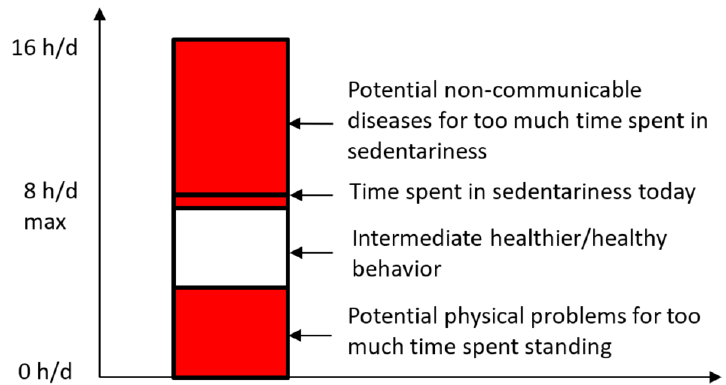
Figure 1. Time spent in sedentariness per waking day.